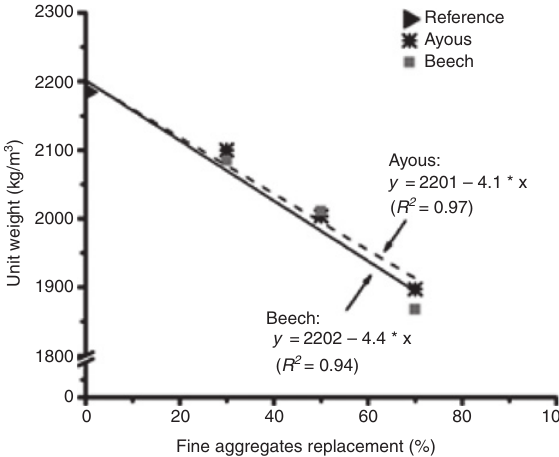
Figure 5: Unit weight of fresh mortar versus % by volume replace- ment of conventional aggregates.